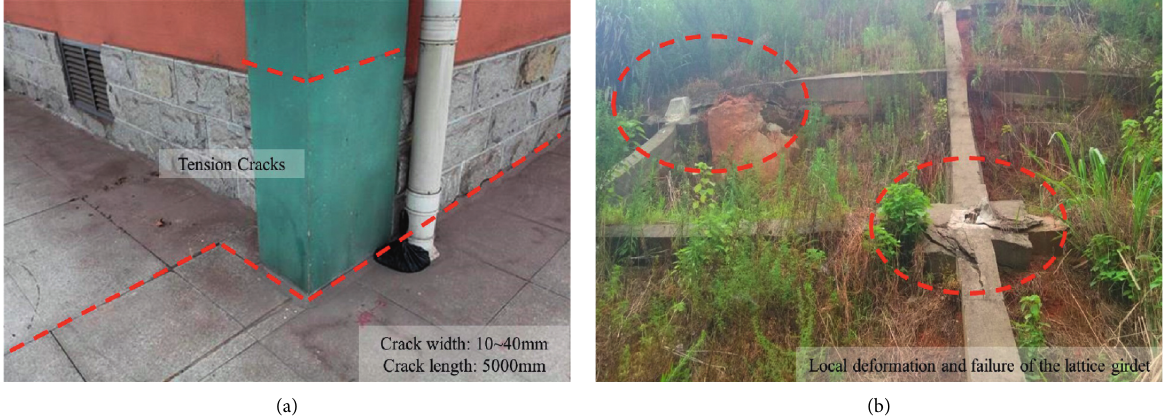
Figure 2: (a) Tension cracks in the exterior wall of museum and (b) local deformation and failure of lattice girder on the east-side slope of north open-pit mine [32].